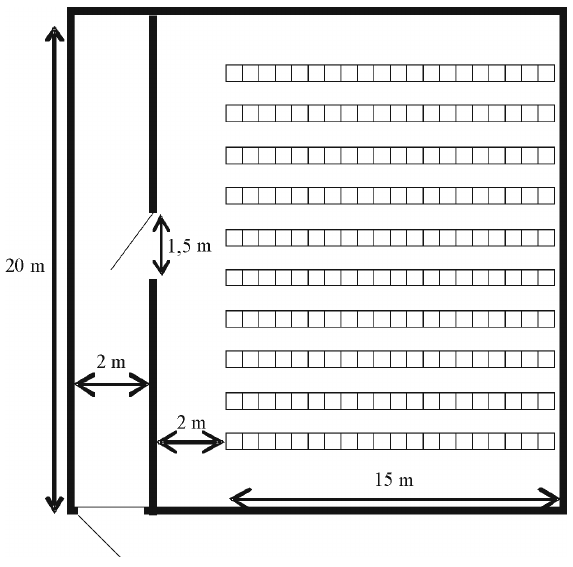
Fig. 2. The plan of the theatre hall and